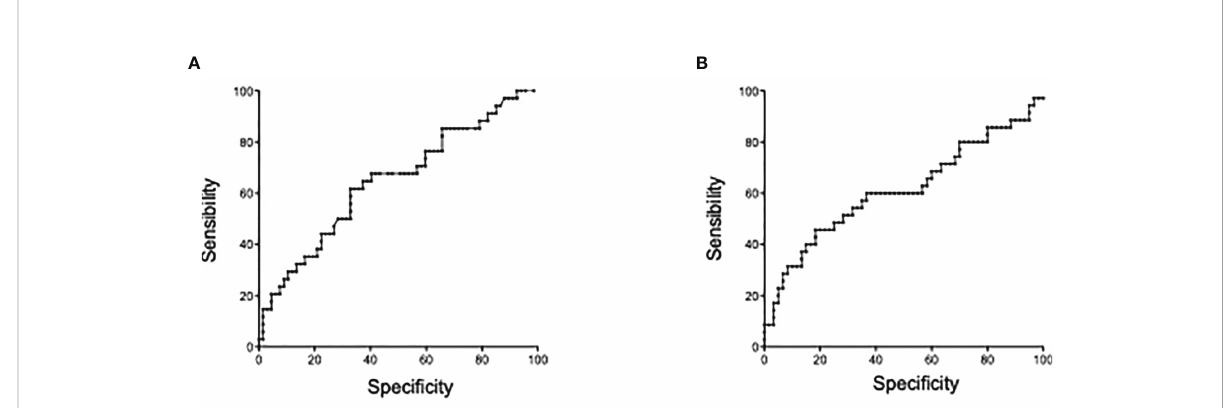
FIGURE 5 Predictors of Crohn ’ s disease relapse within 4 months prior to relapse. (A) Receiver operating characteristic (ROC) curve of comparison between mCRP and risk of relapse at 4 months. (B) ROC curve of IL-17+FOXP3+CD4 T cell numbers and risk of relapse at 4